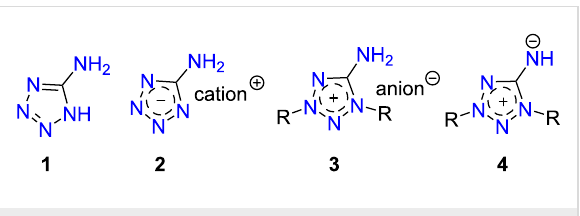
Figure 1: 5-Aminotetrazole